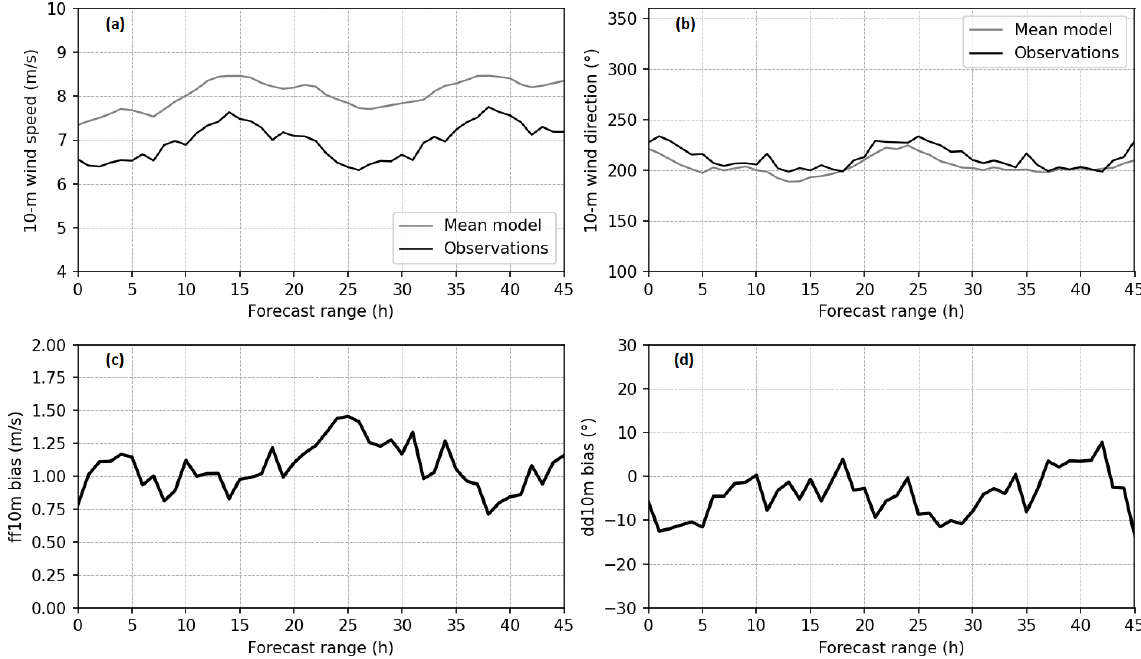
Figure 3. Ensemble mean and observations (a, b) as a function of forecast range, and the resulting bias (c, d) for both 10m wind speed (referred to as ff10m) and direction (referred to as dd10m), aggregated from the two ground measurement stations: La Hague and Gonneville.